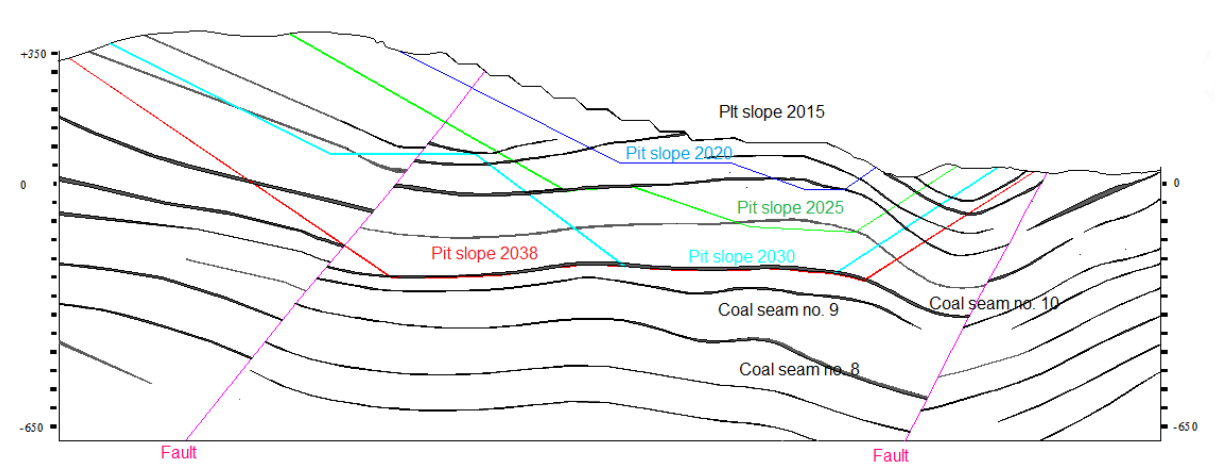
Figure 1: Location of the Cao Son open pit coal mine [37].